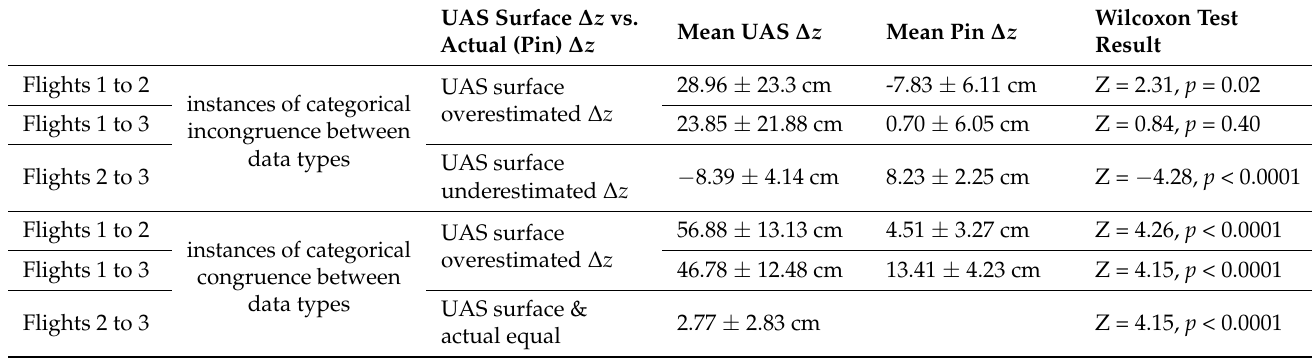
Figure 6. The UAS surfaces typically overestimated the magnitude of ∆ z (cm) relative to the field elevation pin measurements, regardless of whether the two data types were in agreement with the type of change-erosional or accretional-that occurred. Over-estimation ranged from 3–34x the true magnitude observed in situ. Slight differences in collection times could theoretically account for some of these differences, but not to the degree observed given that microscale data show minimal changes in elevation in the absence of an event and there were no events between the temporal incongruence of the datasets. Table 5. Variation in ∆ z calculated from the UAS surface versus pins between flights. UAS Surface ∆ z